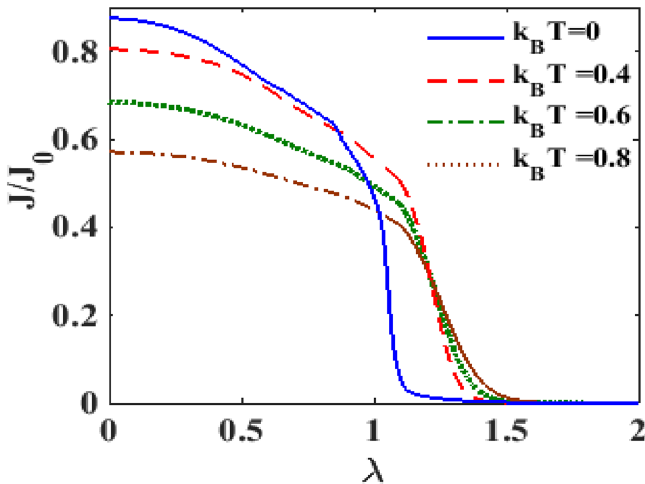
Figure 9. J / J 0 versus (cid:31) for different values of k B T at eV b = 2.5, eV m = 0.5, γ = 0.02 .